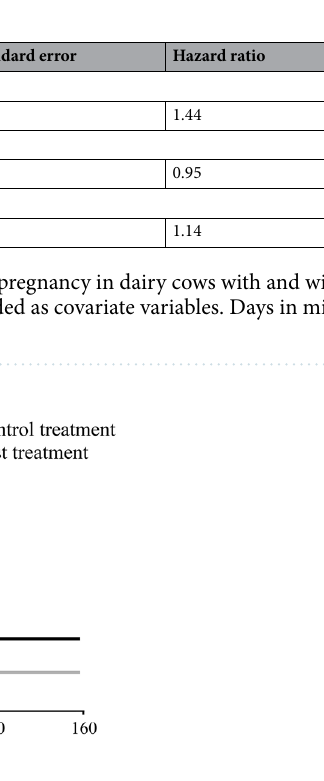
Figure 3. The survival curve of non-pregnancy. The figure was generated from the Kaplan–Meyer survival curve. Categorical variables included treatment, parity, body condition score, sires and farm, whereas days in milk were included as a continuous variable. T1 = Control treatment, T2 = Test treatment.